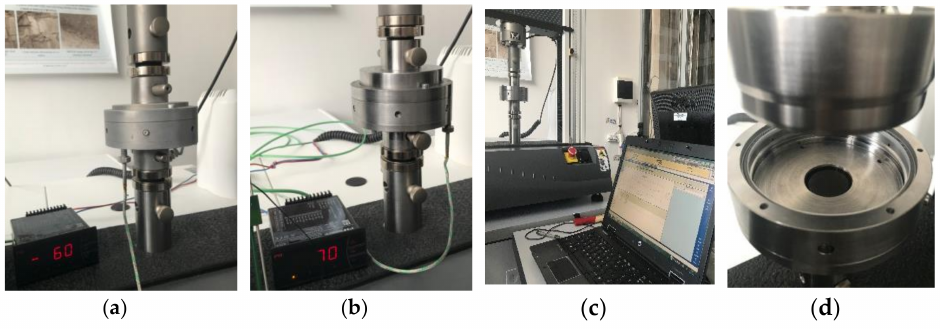
Figure 14. Closing force evaluation for ( a ) − 60 ◦ C and ( b ) +70 ◦ C using a thermocouple and the ( c ) test set-up with ( d ) a detailed view of the testing